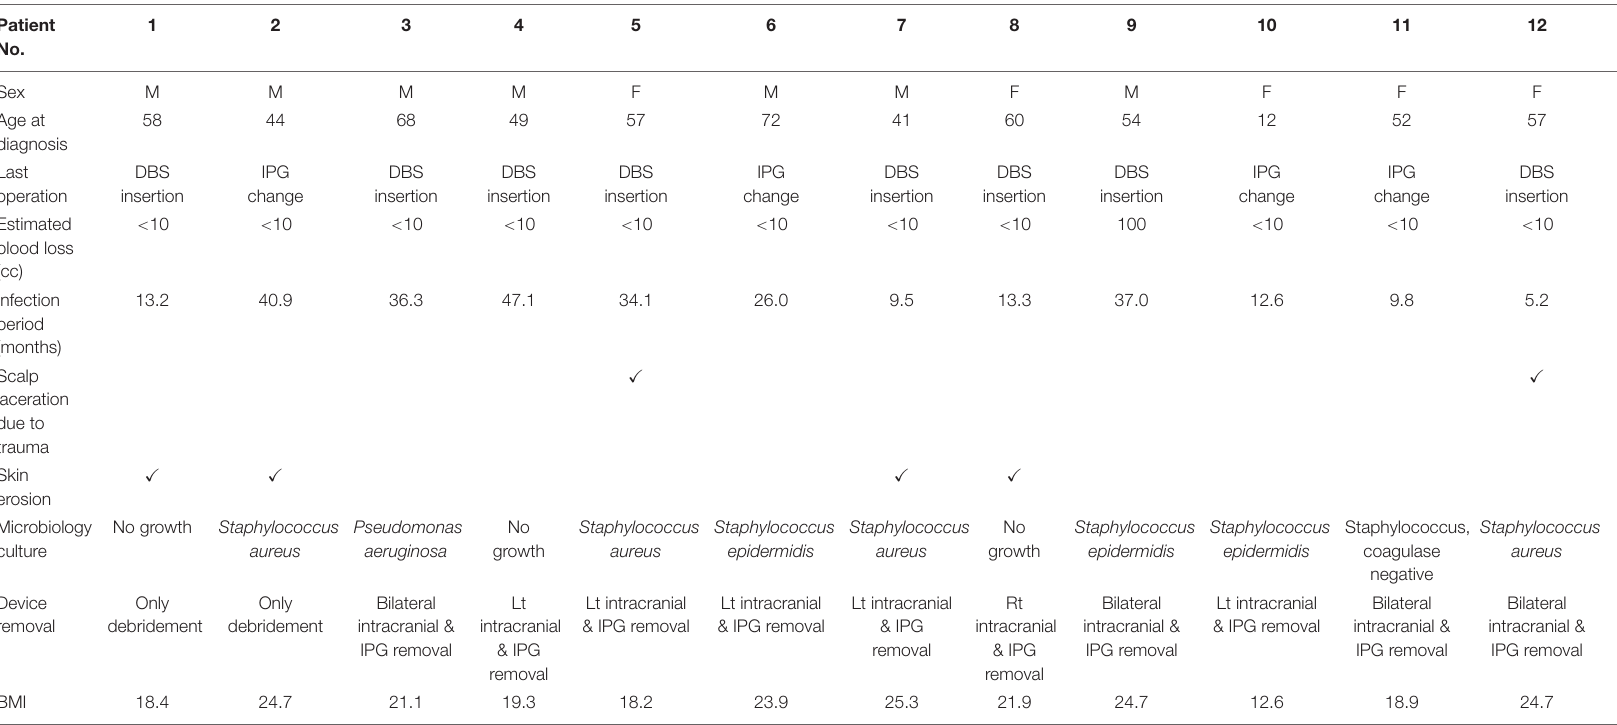
TABLE 1 | Twelve cases of infection after deep brain stimulation. Patient